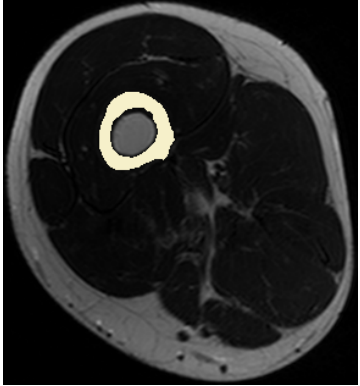
Fig. 11: Slice 12 of segmented